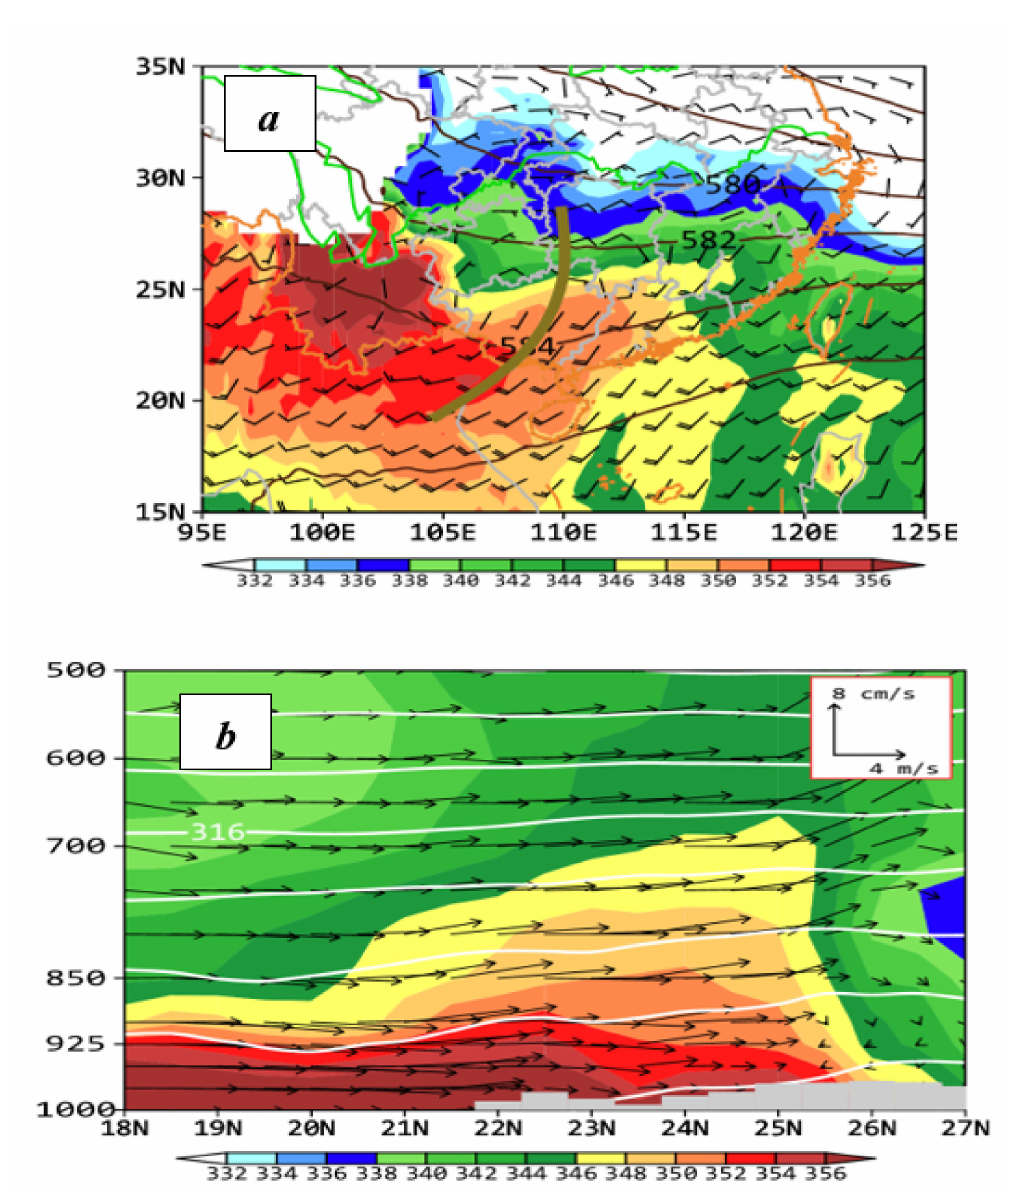
Figure 9. As in Figure 5a,b,respectively, except for the 13 LLV-type WSHR events, with ( b ) along 108 ◦ E through roughly the LLV core region indicated in ( a ) and the HR region indicated in Figure